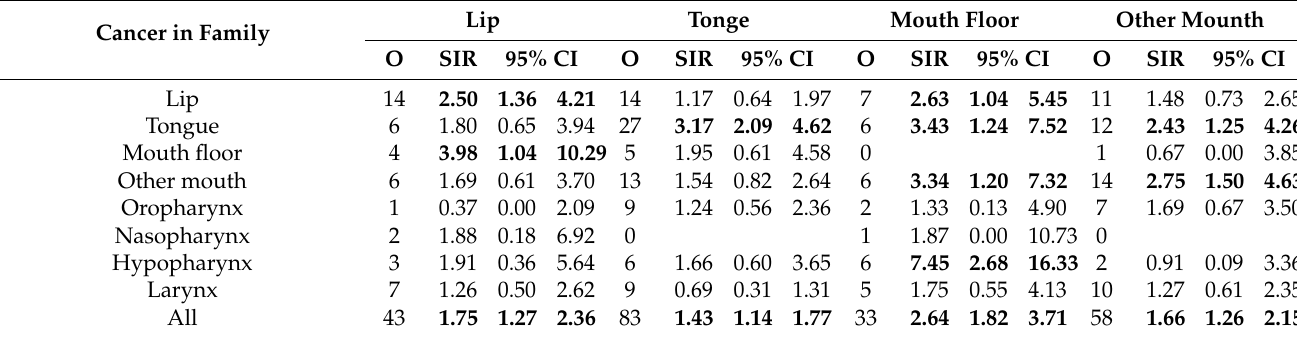
Table 4. Familial risk of site-specific head and neck cancers when family members were diagnosed with site specific head and neck